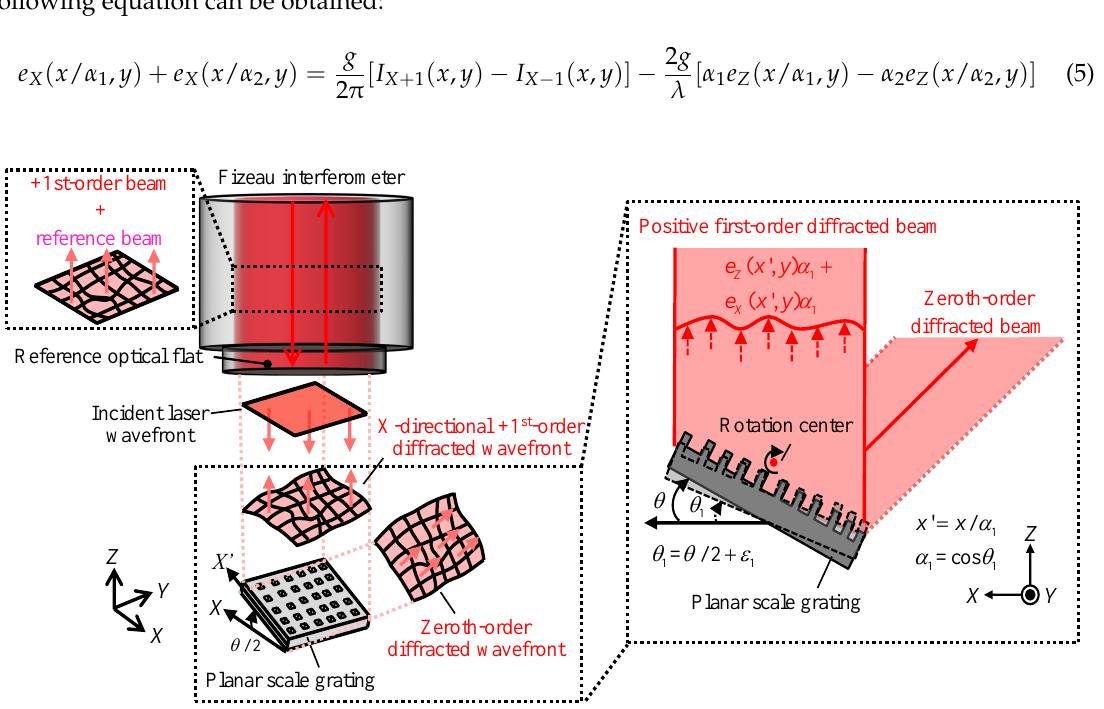
Figure 2. Measurement of X -directional positive first-order diffracted wavefront with inclination error (negative first-order diffracted wavefront is not shown for the sake of simplicity).